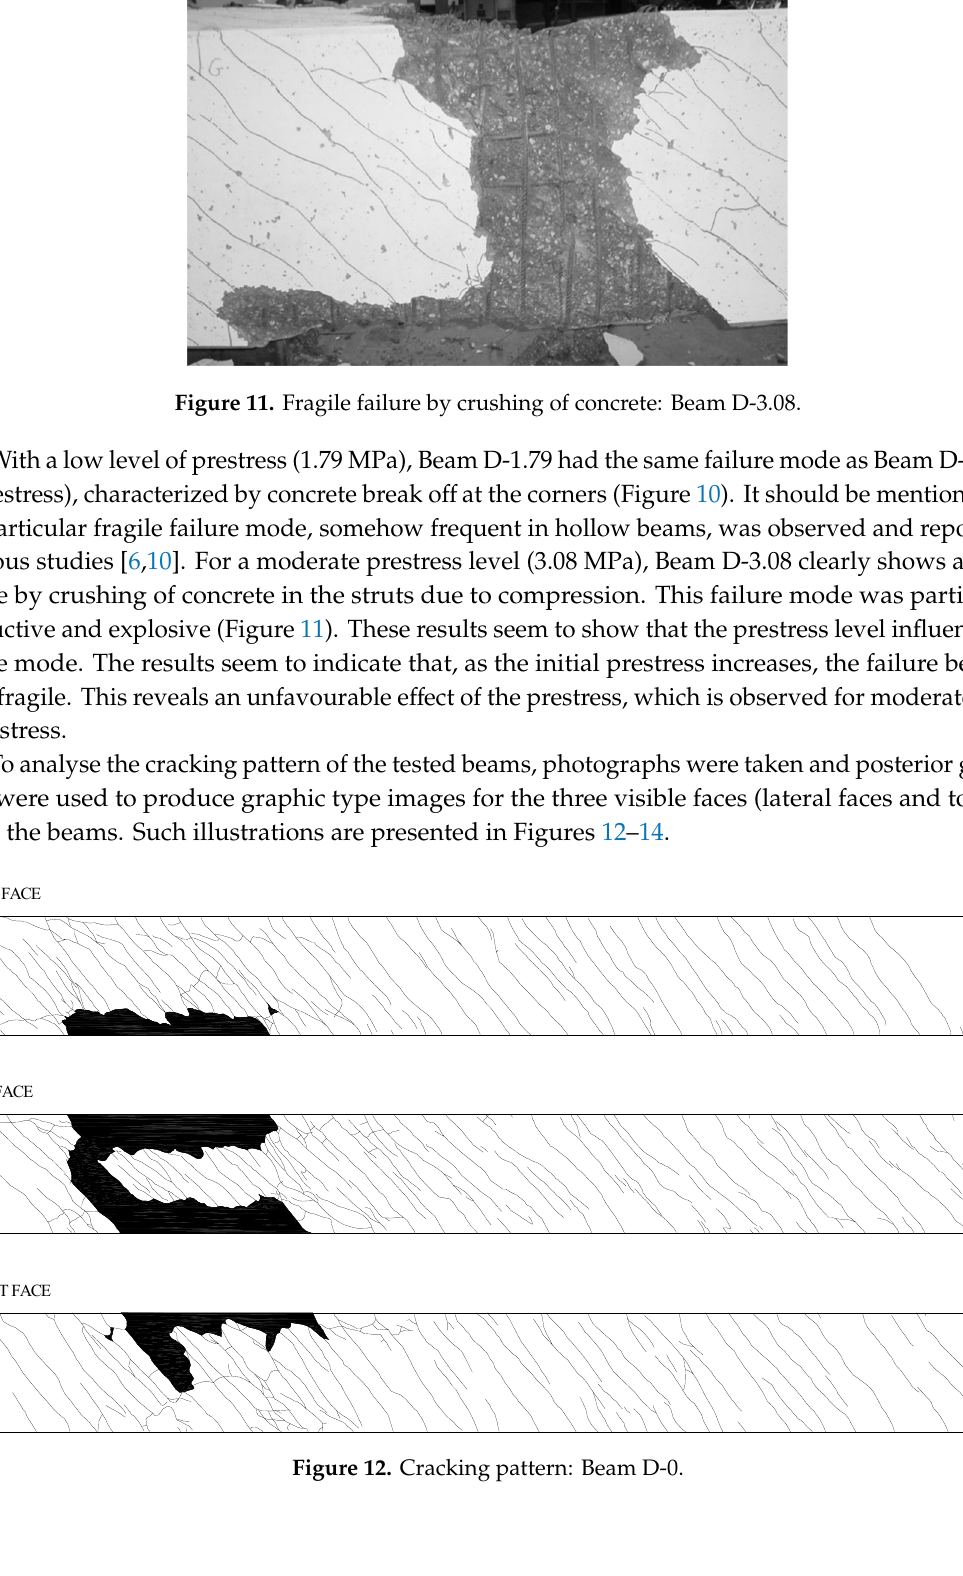
Figure 10. Fragile failure by concrete break off at the corners: ( a ) Beam D-0 and ( b ) Beam D-1.79.